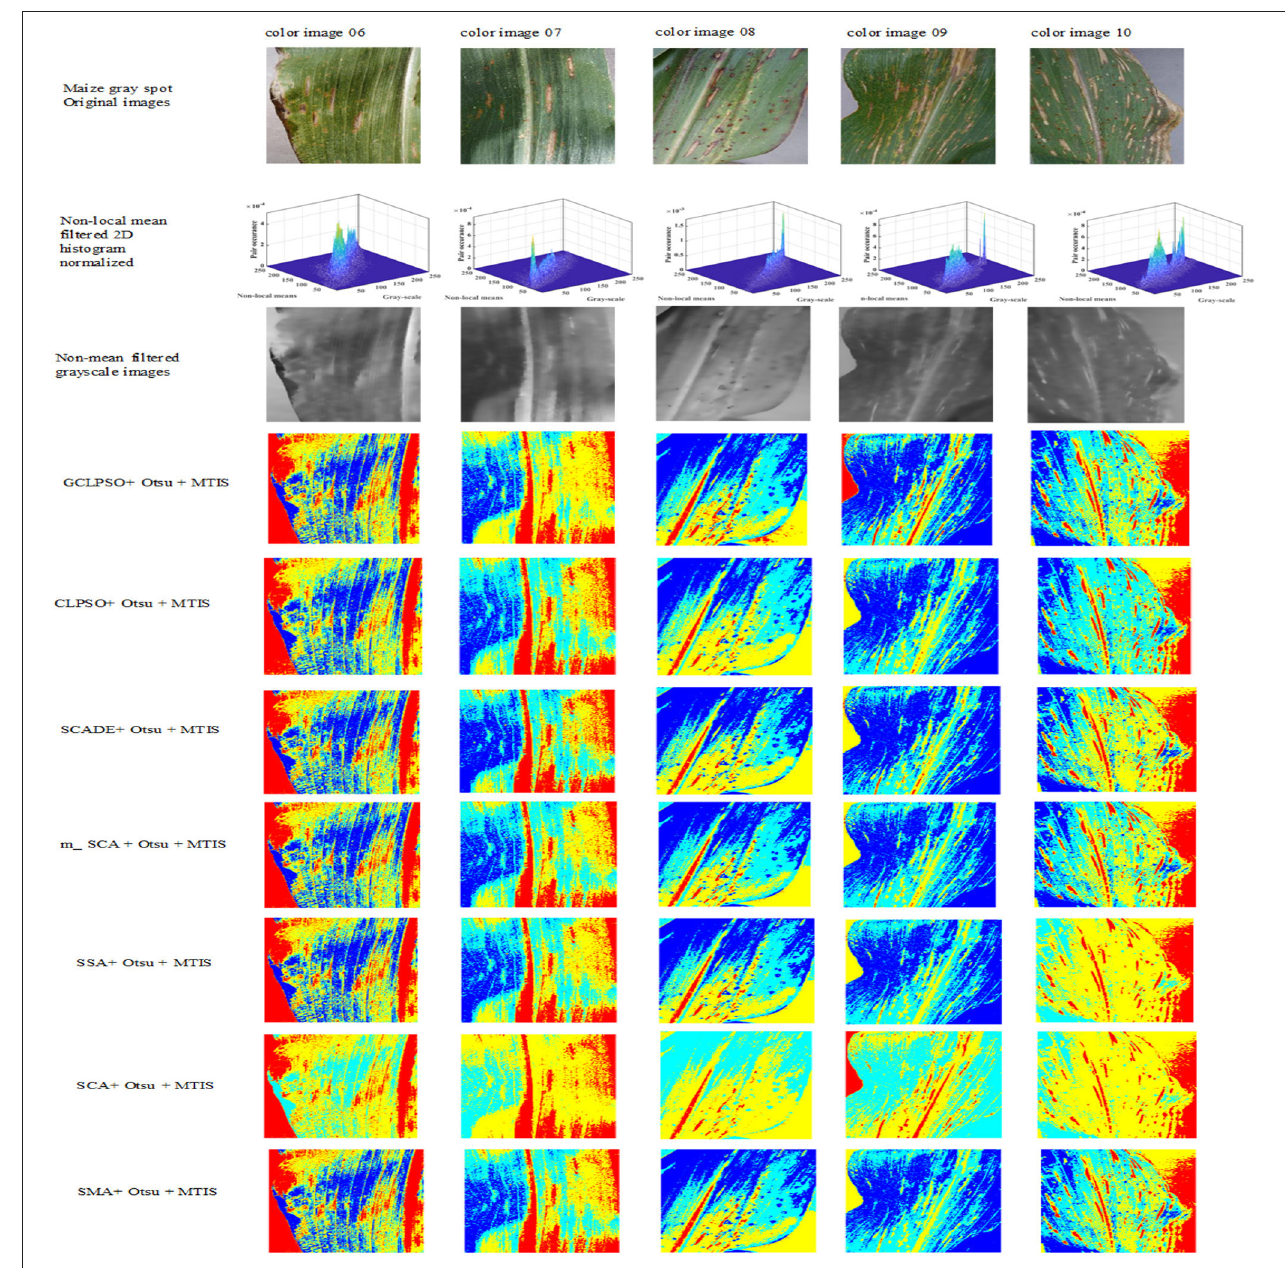
FIGURE 6 | Original images, non-local mean filtered normalized 2D histogram, non-local mean filtered grayscale image results, and three-threshold color image segmentation results of all the algorithms of maize gray spot disease color images 6–10.